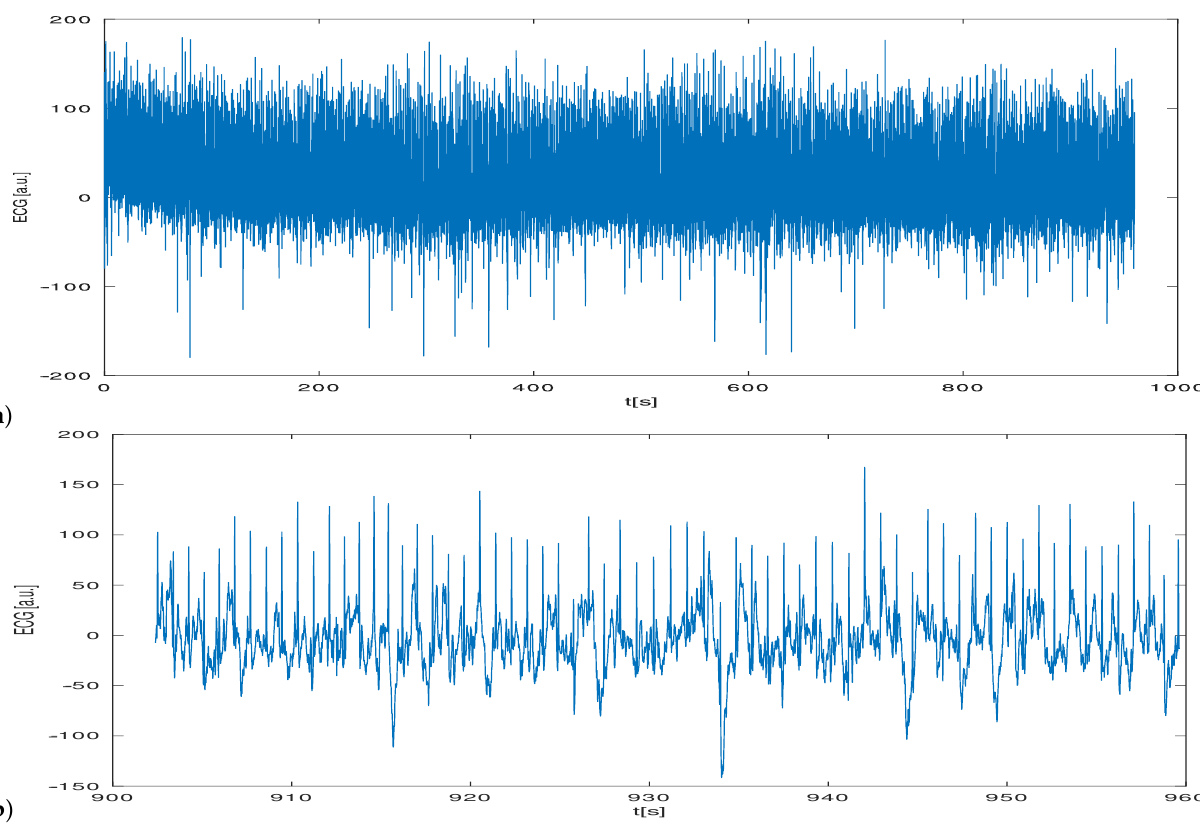
Figure 10. Example of cECG signal recorded for a period of 15 minutes ( a ) and part of the signal shown for a different time scale ( b